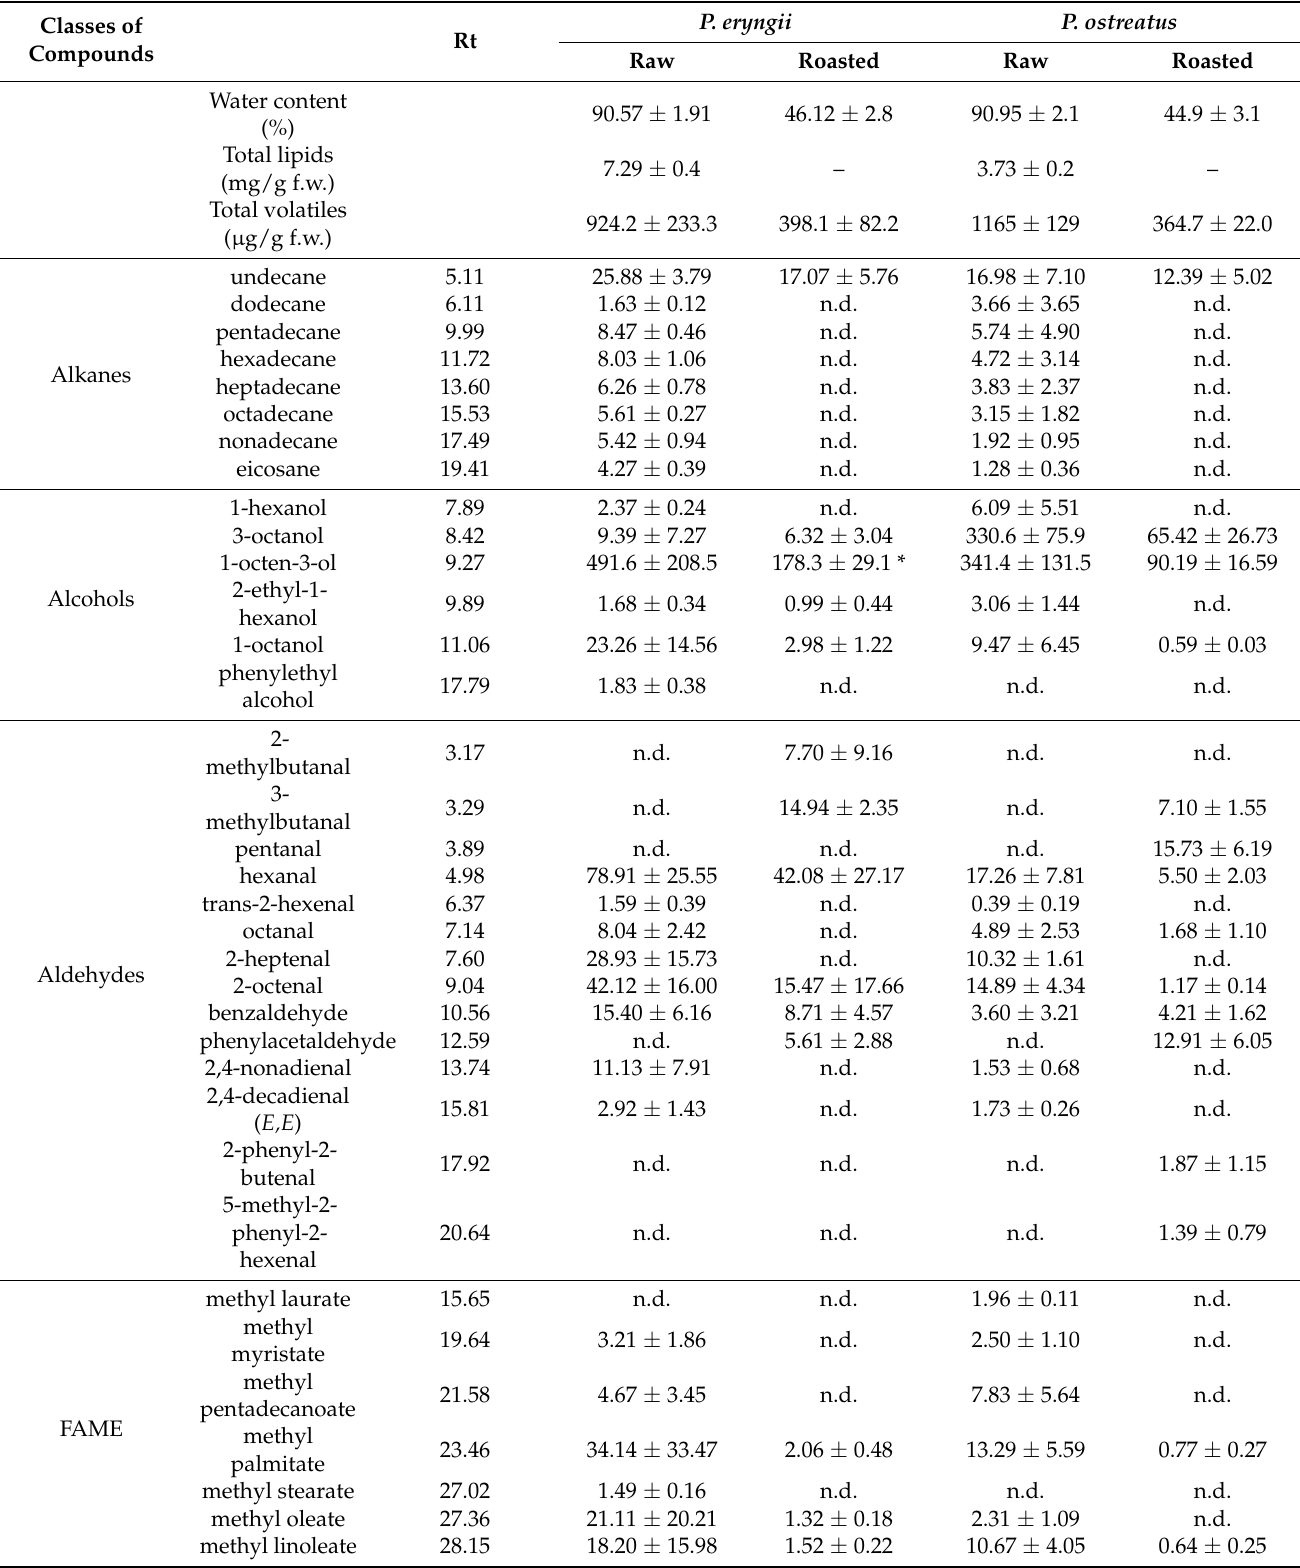
Table 3. Volatile compounds ( µ g/g f.w. equivalents of 4-methyl-2-pentanol) in raw and roasted mushrooms of P. eryngii strain CS3 and P. ostreatus strain LGAM3002 cultivated on wheat straw. Classes